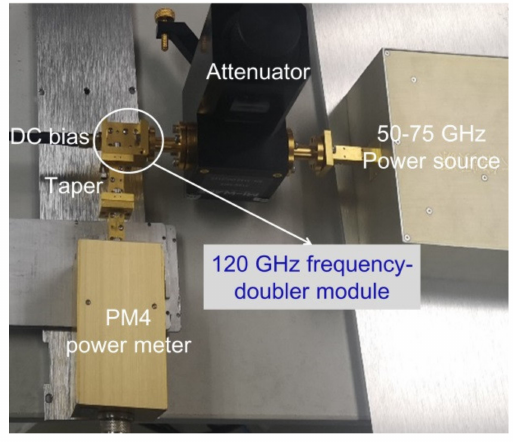
Figure 8. Photograph of test site for the 120 GHz frequency-doubler